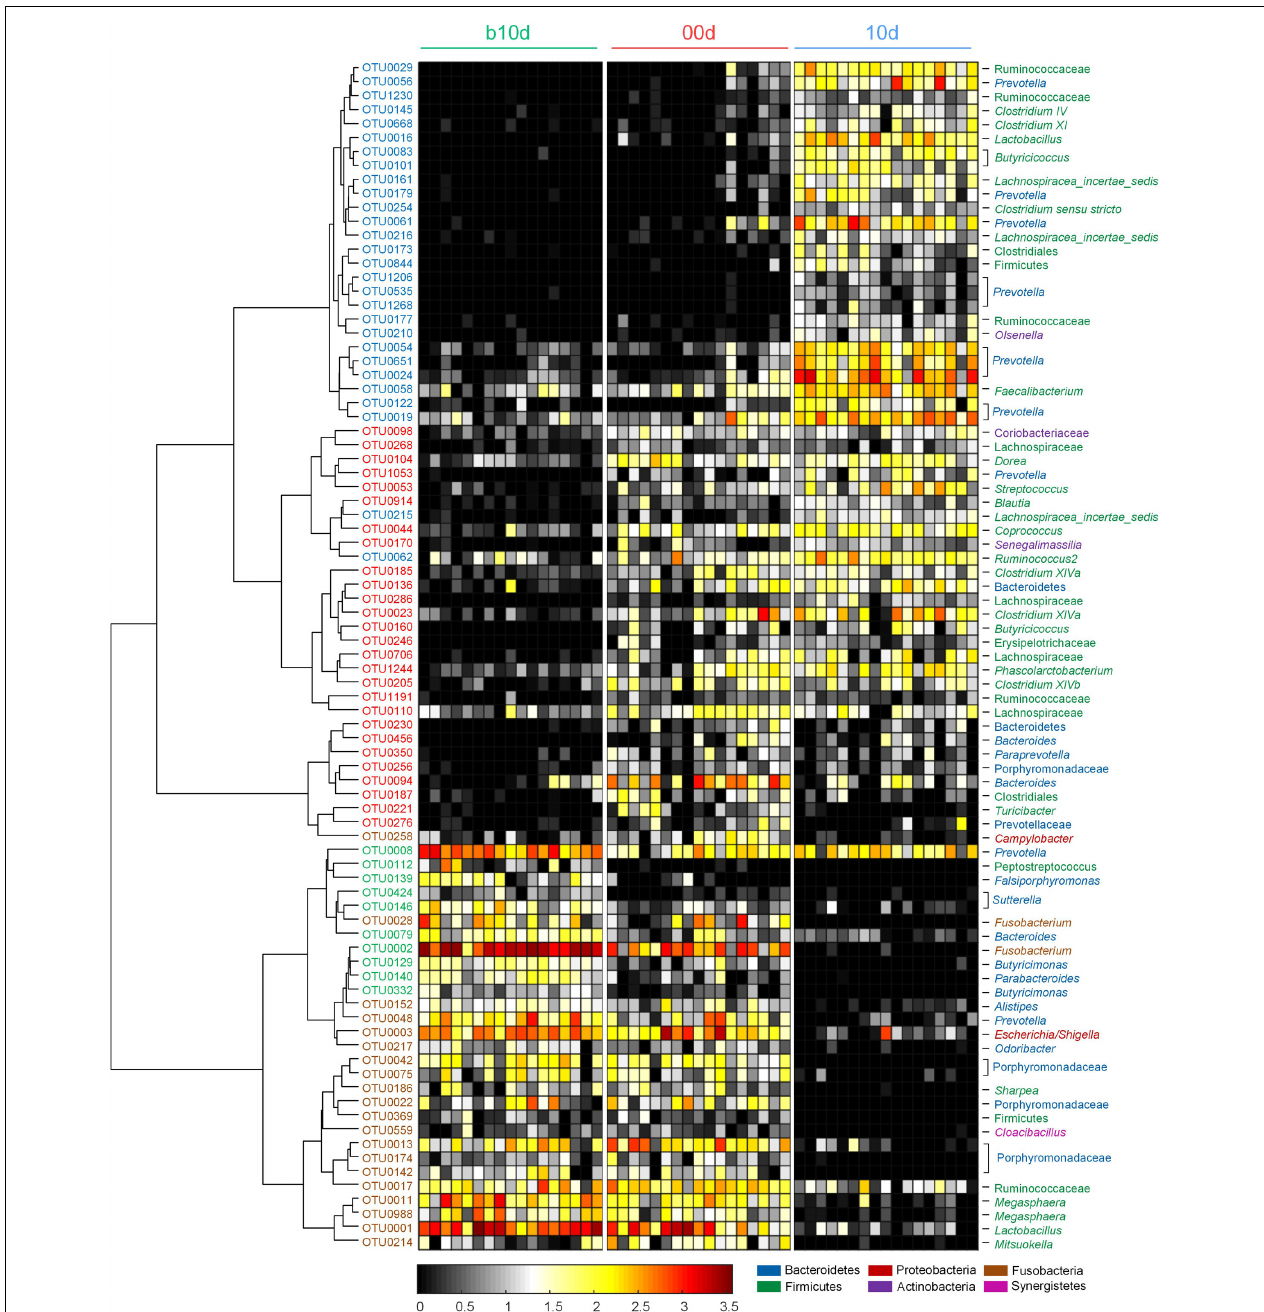
FIGURE 5 | Heat map of 85 key OTUs responding to different age identified by random forest models. The color of the spots in the panel represents the relative abundance (normalized and log-transformed) of the OTU in each sample. The OTUs are organized according to their Spearman correlation coefficient. The OTUs increased in relative abundance from b10d to 00d are marked with red on the OTU id, whereas decreased are marked with green, and the OTUs increased in relative abundance from 00d to 10d are marked with blue on the OTU id, whereas decreased are marked with